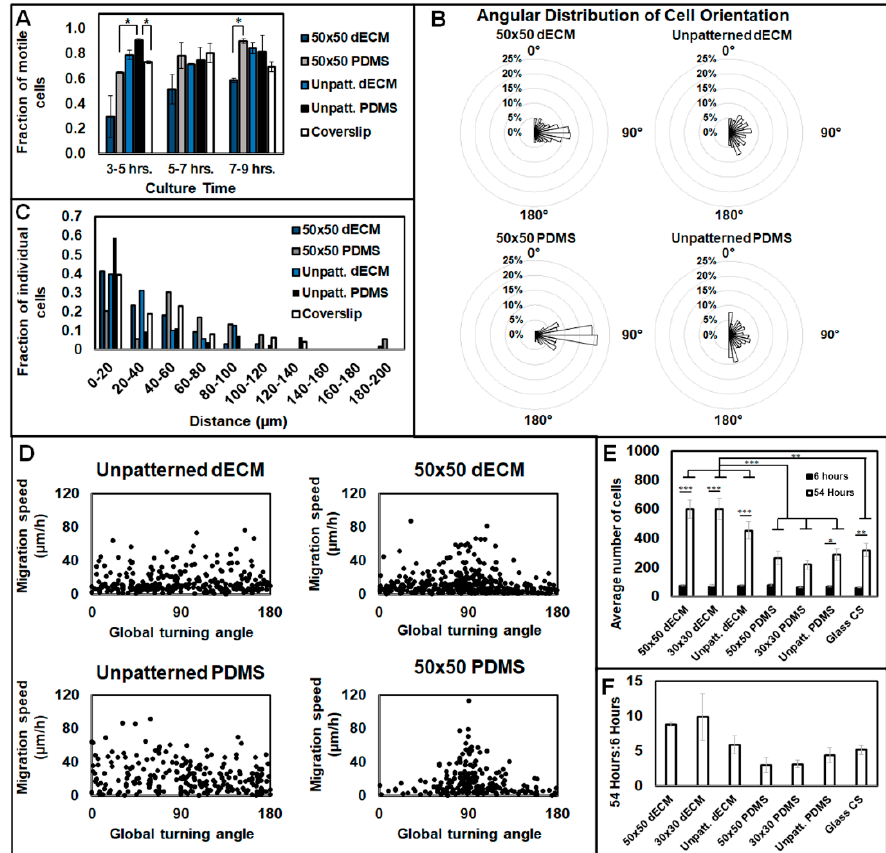
Figure 7. Migration, motility, and proliferation of cells seeded on decellularized ECM. ( A ) The fractions of motile cells for each surface type displayed across two-hour cell culture increments. ( B ) Angular distribution of cell orientation displays the direction of cell migration in 1-h time step increments. Angular bins (10 ◦ ) illustrate the distribution of orientation across trials. ( C ) Fraction of cells displaced across 3 to 8 h of culture for each unique surface. ( D ) Stepwise cell migration speeds as a function of the global turning angle, with respect to the micropattern (where applicable). ( A – D ) Cells were seeded at a density of 5000 cells cm − 1 and cultured for 3 h before time-lapse imaging. n = 2 unique trials per condition with ( A ) > 75, ( B , D ) > 210, or ( C ) > 20 cells. ( E , F ) Proliferation of fibroblast cells on decellularized matrices. (E) Total cells present per image after 6 and 54 h. ( F ) Ratio of the cell counts after 54 h to the average cell counts after six hours. ( E , F ) Cells were seeded at a density of 30,000 cells cm − 1 on both patterned and unpatterned dECM and PDMS; n = 5 images for each unique trial, with 3 unique trials per condition. Data are presented as mean ± SE, where * p ≤ 0.05, ** p ≤ 0.005, and *** p ≤ 0.001.